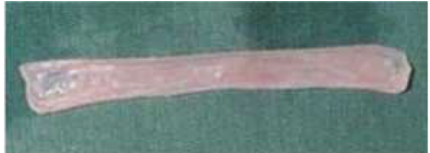
Figure 1: Mucosa of the inverted intestinal segment isolated.